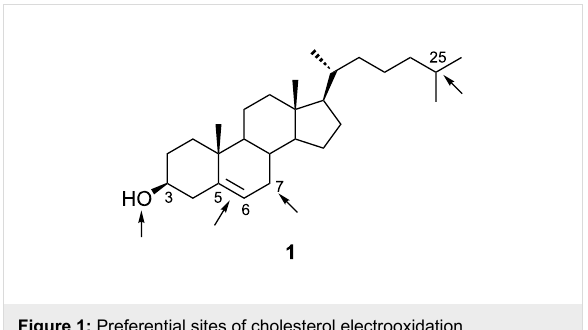
Figure 1: Preferential sites of cholesterol